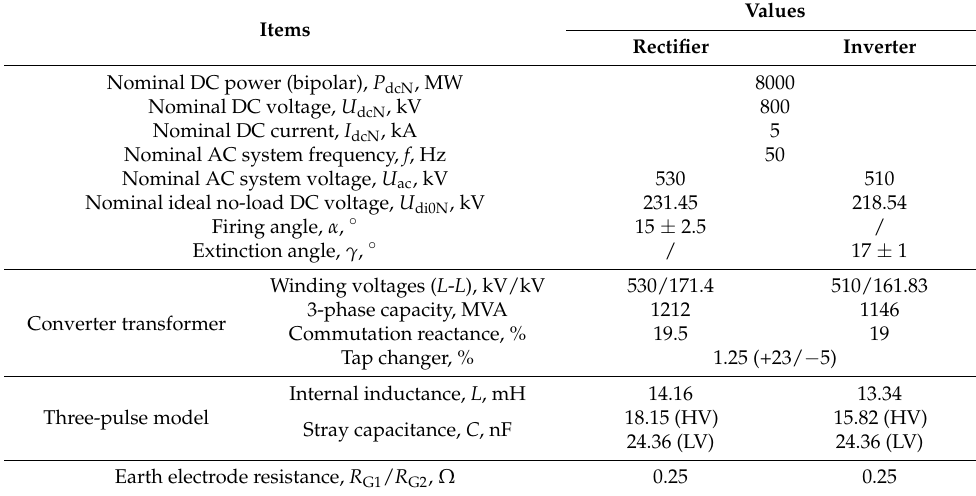
Table 1. Parameters of converter stations.